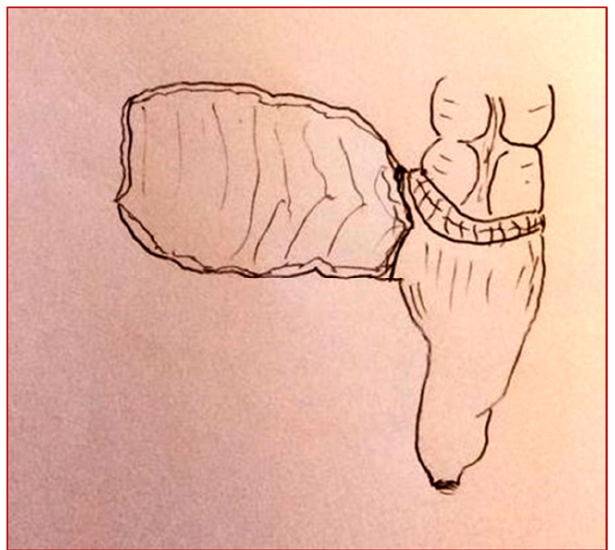
Figure 5. Cologne pouch technique: intestinal detubularization and creation of the pouch. Children 2021 , 8 , x FOR PEER REVIEW